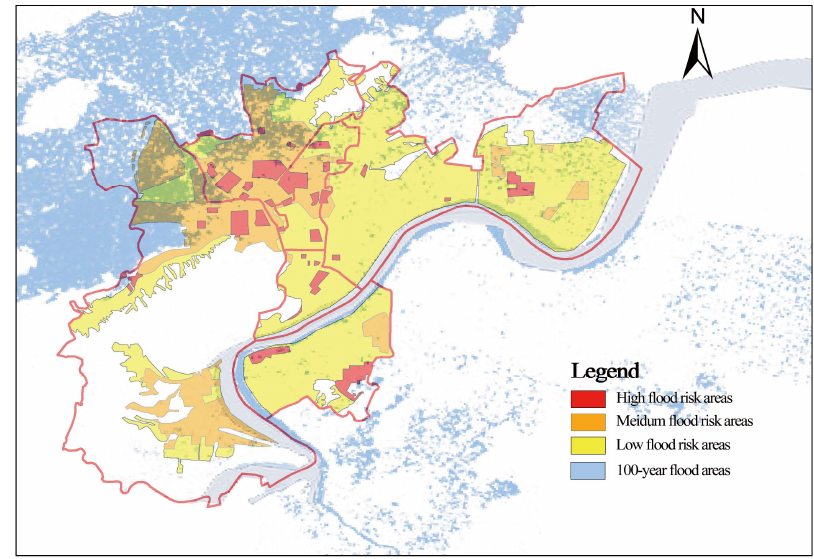
Figure 3. Flooding risk map.